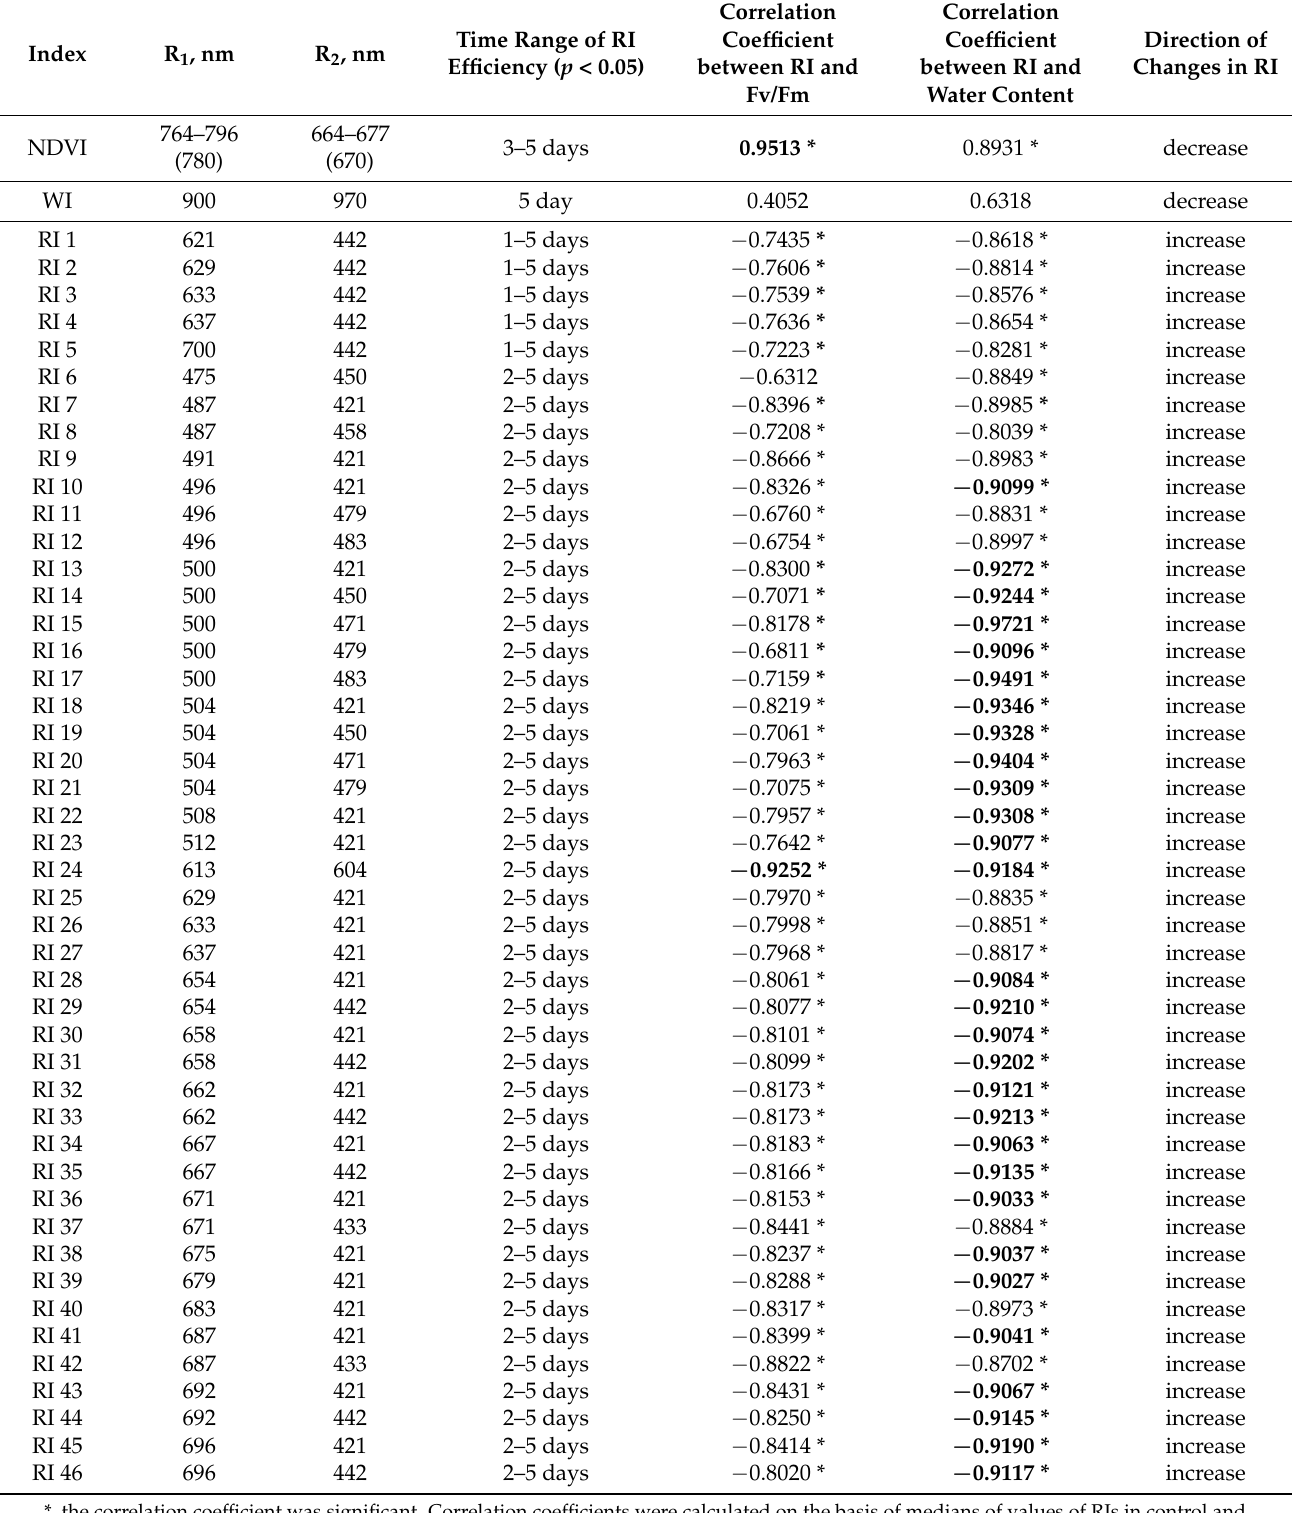
Table 2. Time ranges of efficiencies of absolute values of RIs for the water shortage sensing and correlation coefficients between RIs and investigated physiological parameters (Fv/Fm and the relative water content in leaves). Correlation coefficients with absolute values more than 0.90 are marked by